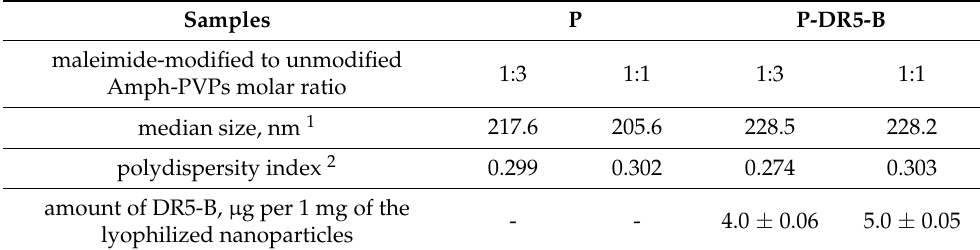
Table 1. Size, polydispersity and sorption capacity of Amph-PVP-based nanoparticles depending on